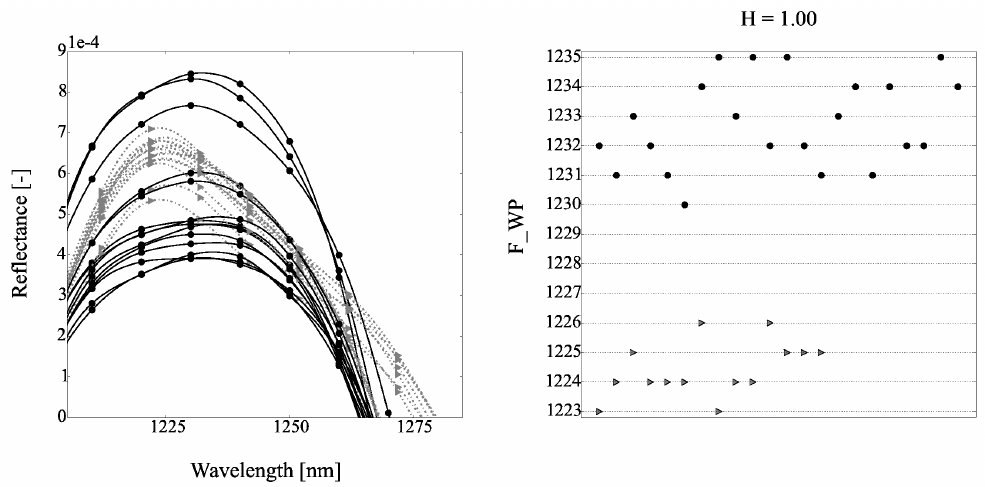
Figure 11. ( Left ) spectral signatures of SPHA (black) and Calluna vulgaris (CAVU) (gray); ( Right ) F_WP values for each vegetation type, H is the Hellinger